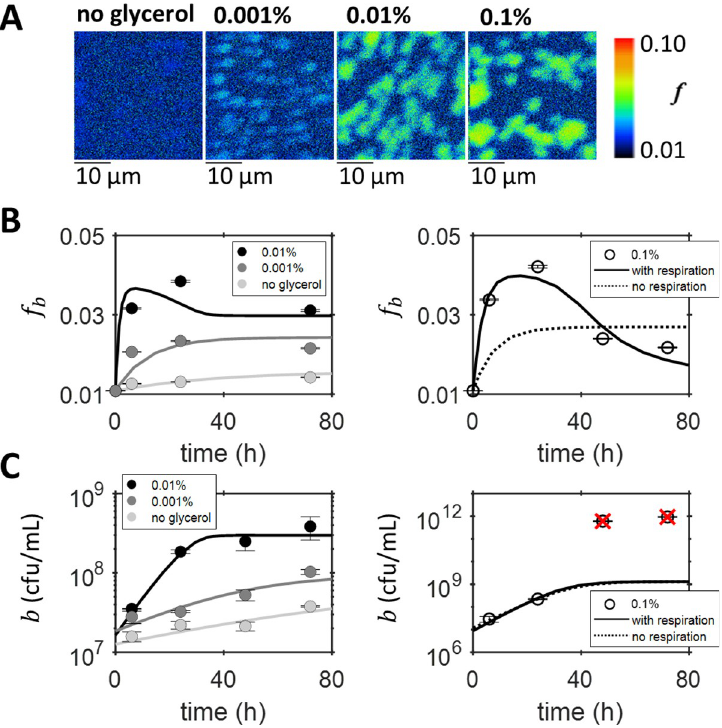
Fig 2. Inorganic carbon acquisition by axenic bacteria. (A) Example images of the atomic fraction of 13 C , f , obtained by SIMS analysis of bacterial cells sampled after 24 h of axenic cultures grown with different concentrations of unlabelled glycerol and 5 mM NaH 13 CO 3 . The colour map shows the scale, starting at natural abundance. (B) The mean atomic fraction of 13 C , f , for dilution-corrected SIMS measurements (for the 0–0.01% glycerol cultures on the b left and 0.1% glycerol culture on the right) demonstrate inorganic carbon acquisition by the bacteria. Error bars correspond to standard errors. (C) Bacterial growth measured using viable counts, plotted on a logarithmic scale as the mean of two measurements (with standard error shown as error bars), shows an increase in the exponential growth rate and carrying capacity for higher initial concentration of glycerol (0–0.01% glycerol cultures shown on the left and 0.1% glycerol culture on the right). Red crosses indicate points that were unexpectedly high (approximately 1 × 10 12 cfu mL − 1 ) and therefore considered outliers and not included in the parameter optimisation. The results of fitting the model to both the growth and SIMS data, with parameters and their units as specified in Table 1, are also plotted for the (B) atomic fraction f b and (C) cell density b . For the 0.1% glycerol culture, shown separately on the right, results from two different parameter optimisations are compared. For the fit including respiration (solid line), i.e. with η as a free parameter, the results are given in Table 1. For the fit neglecting respiration (dotted line), i.e. η 0 = 1, the parameter optimisation results are K c = 6.6 × 10 − 6 molC mL − 1 , μ b = 0.15 h − 1 and for the 0.1% glycerol culture b (0) = 1.2 × 10 7 cells mL − 1 and X =